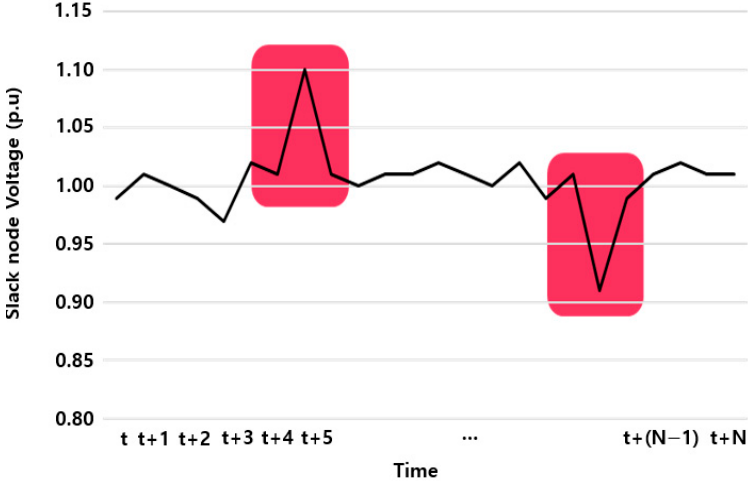
Figure 8. Special Event of slack node voltage. In Figure 6, the power equation of T-node 1 at the time 𝑡 + 1 defined in (21) can be